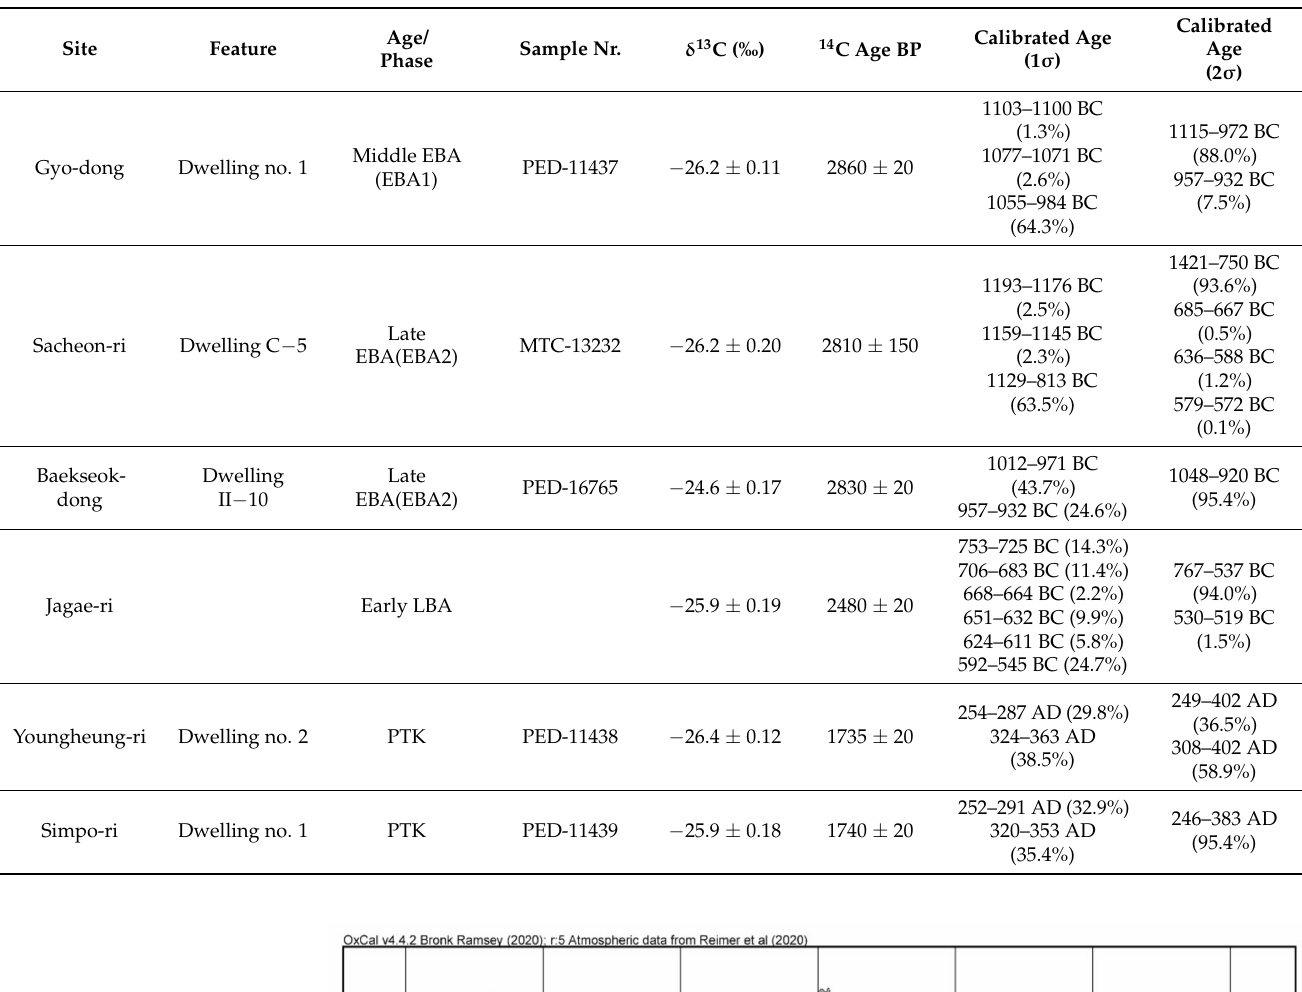
Table 1. The rice grain samples for AMS dating and their calibrated ages. Calibration was performed using Oxcal v.4.4.2 [46], with atmospheric data by [47].